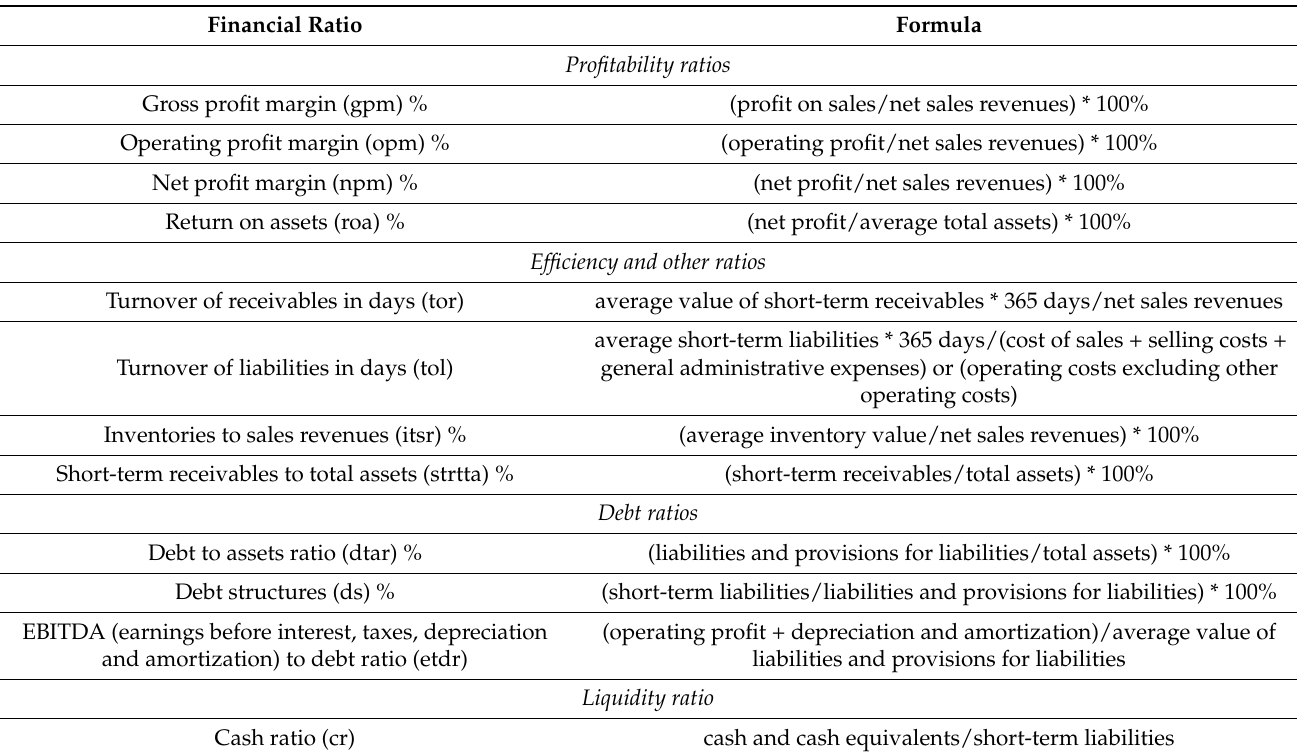
Table 3. Financial ratios and their calculation